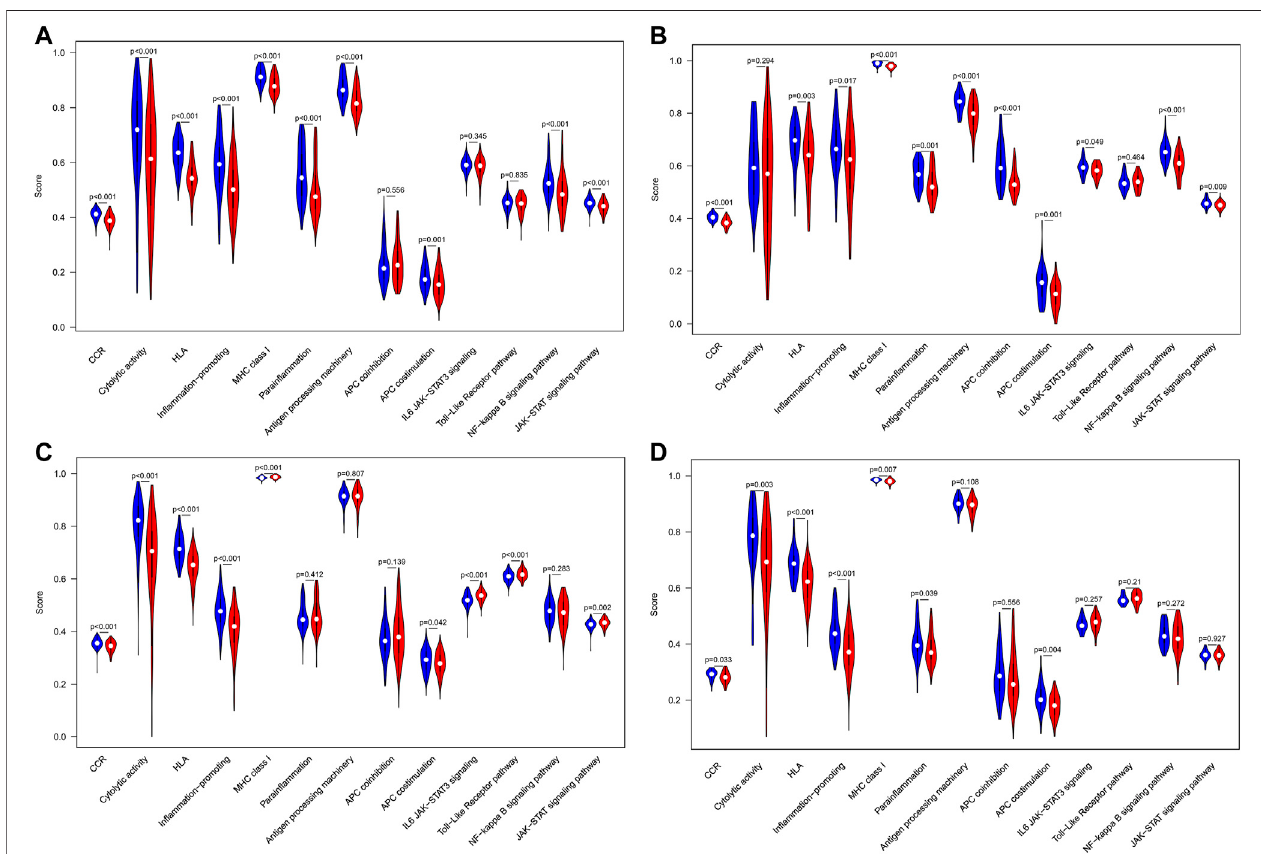
FIGURE 9 | Comparison of immune-related pathways between different HLA subgroups in the discovery cohorts. (A) GSE65682 datasets. (B) GSE63042 datasets. (C) E-MTAB-4421 datasets. (D) E-MTAB-4451 datasets. Blue indicates HLA low-risk, while red indicates HLA high-risk.